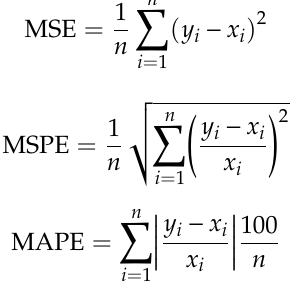
Figure 21. The mean absolute percent error of the five models. Table 5. The MSE, MSPE and MAPE values for five